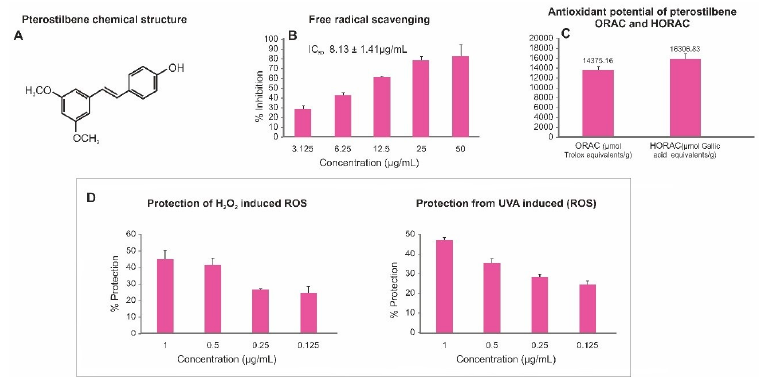
Figure 1. Anti-oxidant activity of pterostilbene. ( A ) Pterostilbene chemical structure; ( B ) free radical scavenging; ( C ) antioxidant potential of pterostilbene Oxygen Radical Absorption Capacity Assay ORAC and Hydroxyl Radical Antioxidant Capacity Assay HORAC; ( D ) protection from reactive oxygen species (ROS). The sun protection factor (SPF) is the most critical data to quantify the effectiveness of sunscreens, which is universally accepted [34]. The present study aimed to determine the SPF of the 90% natural pterostilbene as an ingredient and in a cream formulation In Vitro and in vivo in human volunteers.